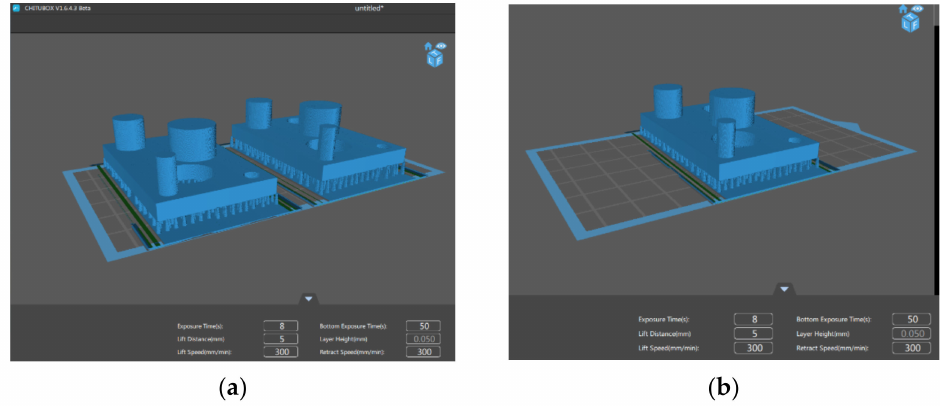
Figure 2. The generation of the 3D printed parts: ( a ) at lower and upper value; ( b ) at the median